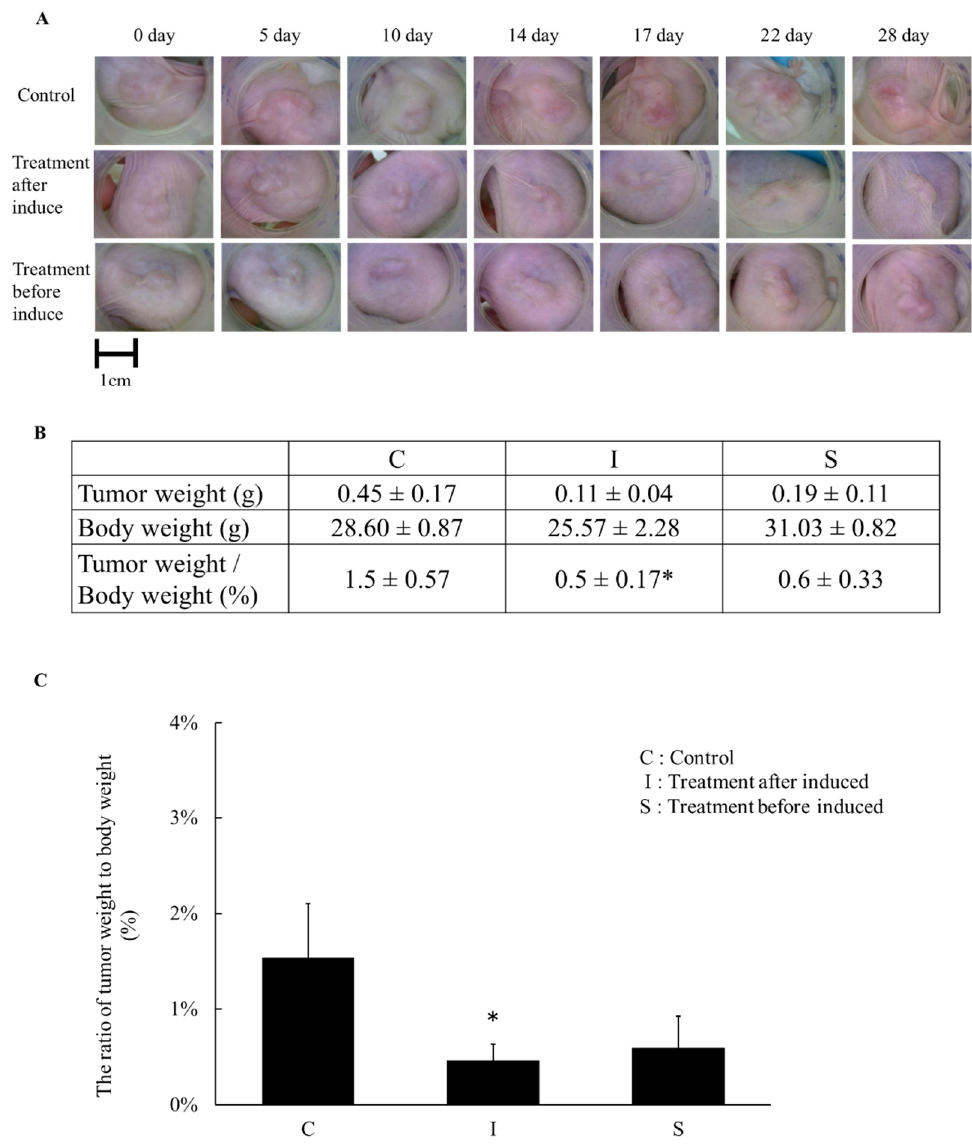
Figure 5. Xenograft subcutaneous tumor animal model (PANC-1). ( A ) Gross pictures of tumor size from day 0 to day 28. Control: tumor-induced control; implant pre-treated cells and simvastatin treatment after being induced (I); implant pre-treated cells without simvastatin treatment after being induced (S). ( B ) The tabular data of three groups. ( C ) The tumor weight and body weight ratio among the three groups on day 28. The pre-treated simvastatin cell implants and intraperitoneal simvastatin treatments after implantation significantly decreased the tumor weight and body weight ratio. ( n = 6) * p < 0.05 when compared to the control group.